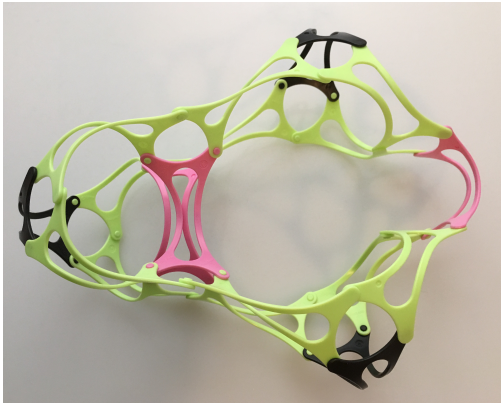
Figure 13. A unit-woven double torus with the code word [{[}[{]{]}]}. Hamiltonian circuit in